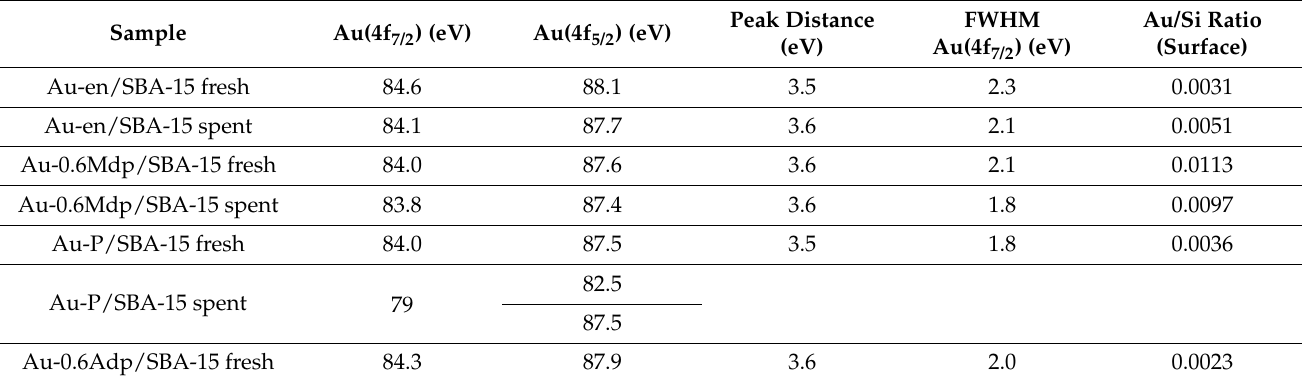
Table 1. XPS features of all samples.